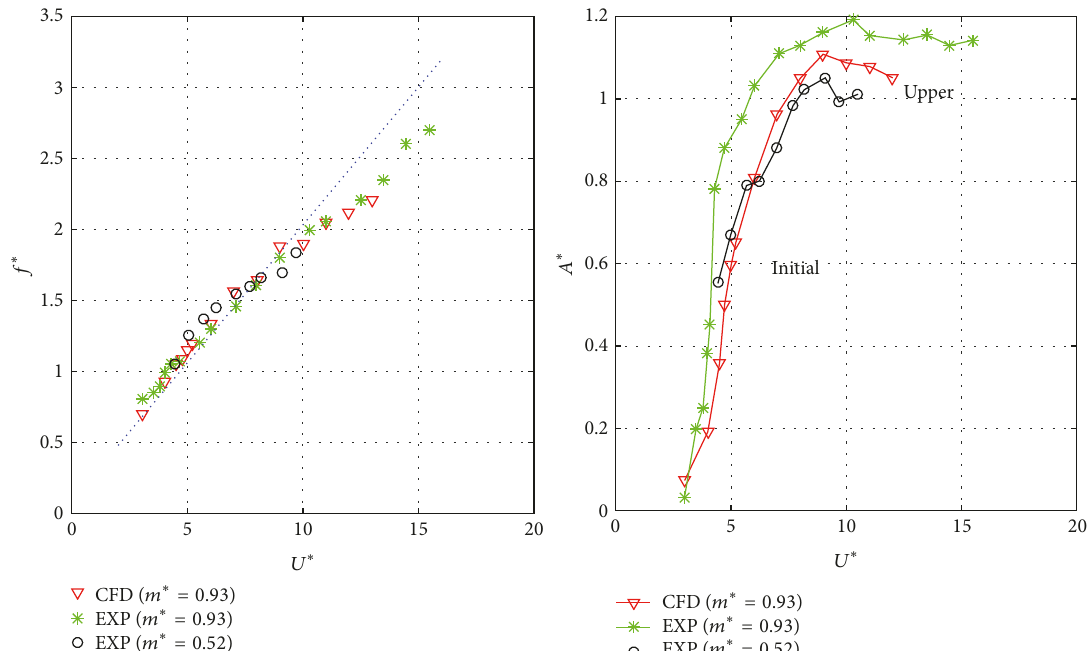
Figure 6: Comparison of amplitude and frequency responses between the numerical results and the experimental results.